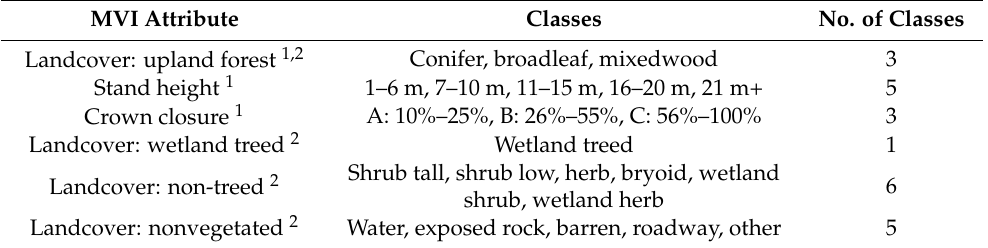
Table 1. Class structure of the polygon version of the Multisource Vegetation Inventory (MVIv). MVI Attribute Classes No. of Classes Landcover: upland forest 1,2 Conifer, broadleaf, mixedwood 3 Stand height 1 Landcover: wetland treed 2 Wetland treed 1 Shrub tall, shrub low, herb, bryoid, wetland Landcover: non-treed 2 shrub, wetland